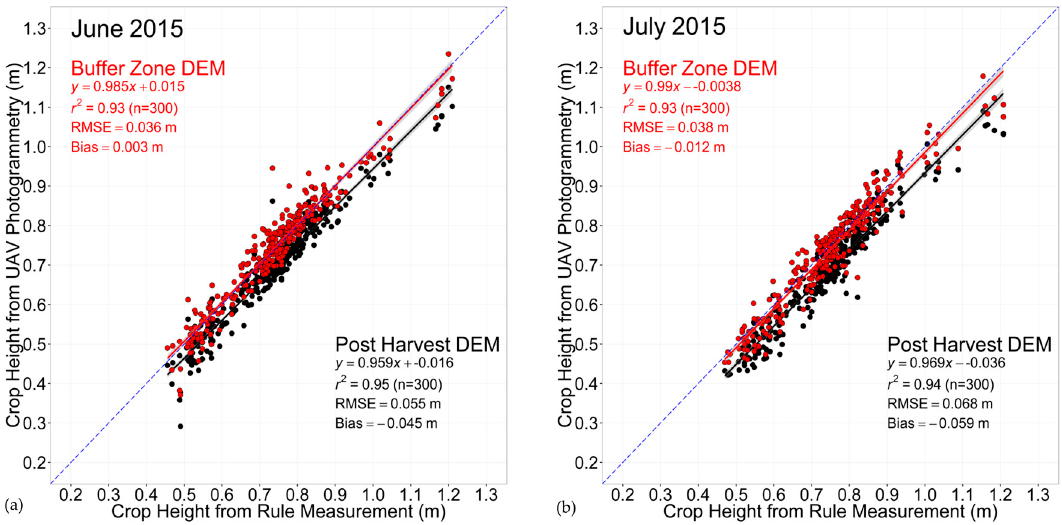
Figure 9. Comparison of “buffer zone” ( red ) and “post-harvest” ( black ) DEM generated crop heights for June ( a ) and July ( b ) 2015. The blue dashed line indicates a 1:1 slope.